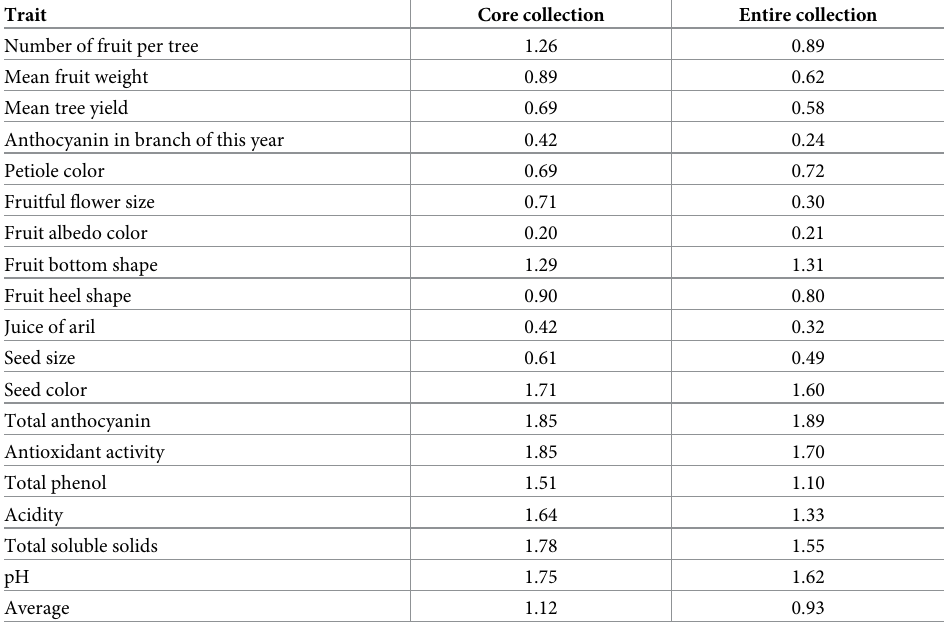
Table 3. Shannon-Weaver diversity index for morphological and biochemical traits in the core and entire collec- tion of pomegranate.